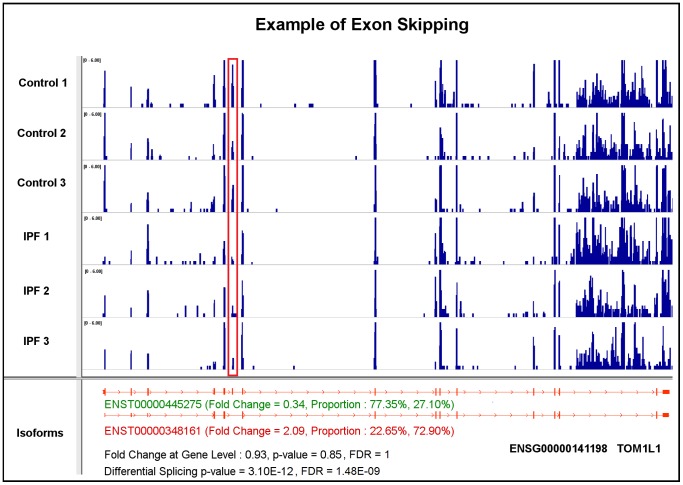
A case study of gene TOM1L1 illustrating the skipping exon splicing mechanism using the annotated transcripts.